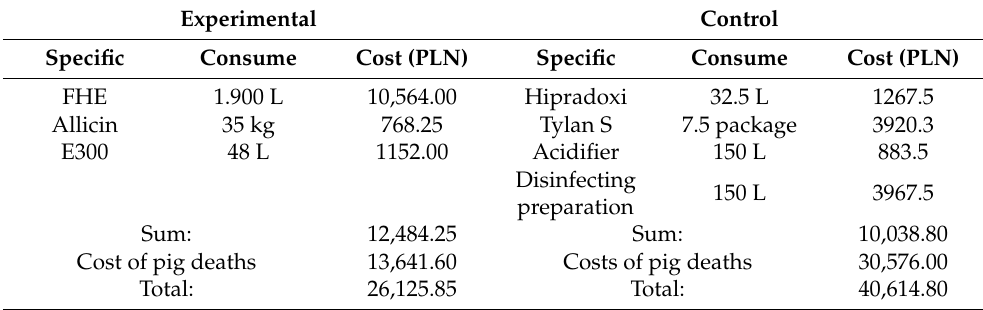
Table 3. Economic calculation of two pig production systems.